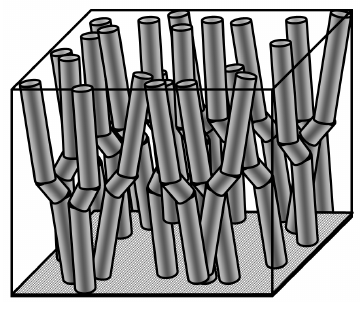
Figure 5. A schema of the multifiber unit cell with random misalignments and fiber misalignments. Figure 6. A schema of the multifiber unit cell with random misalignments and fiber